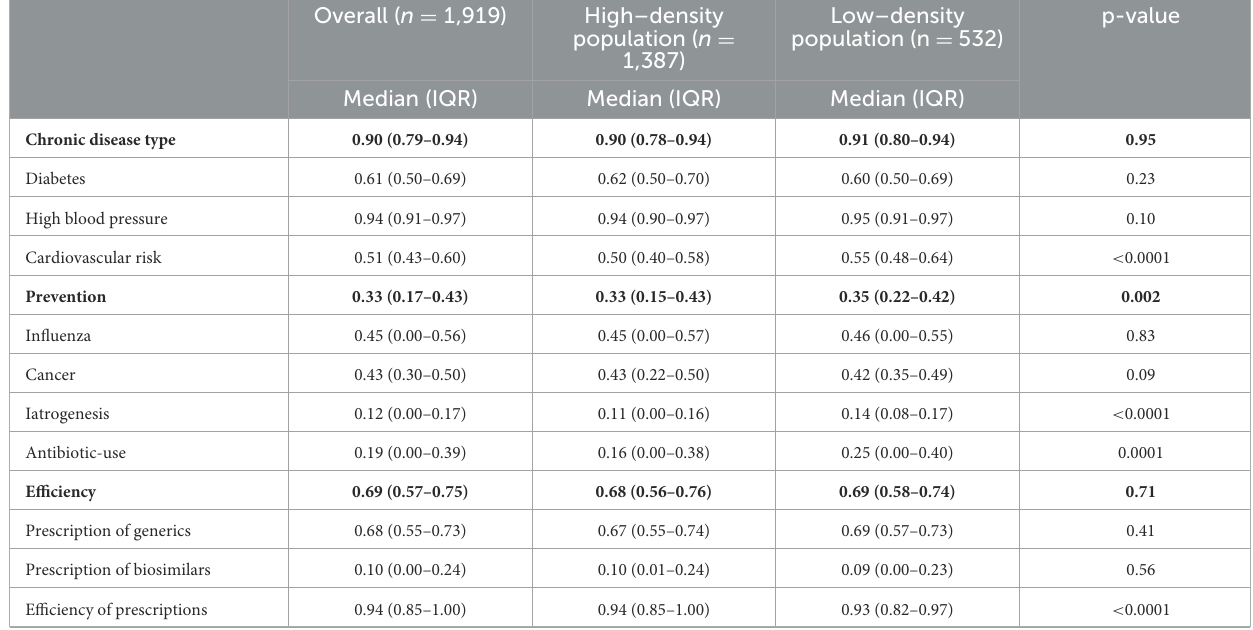
TABLE 3 Comparison of remuneration based on public health objective (ROSP) scores between high- and low-population-density areas in the Aube department between 2017 and